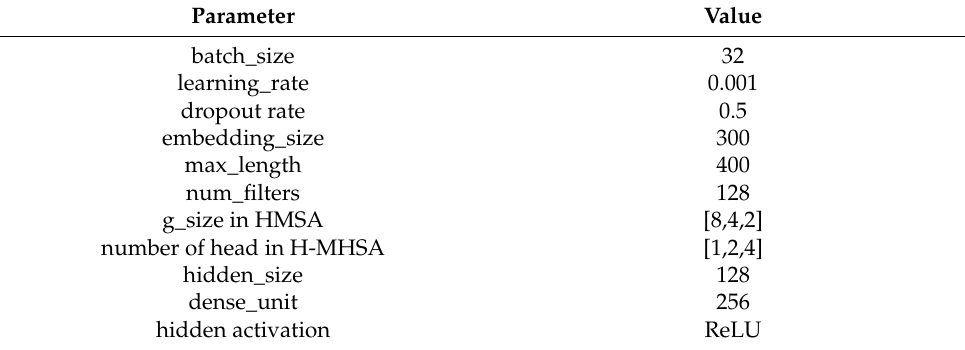
Table 2. Overall parameter